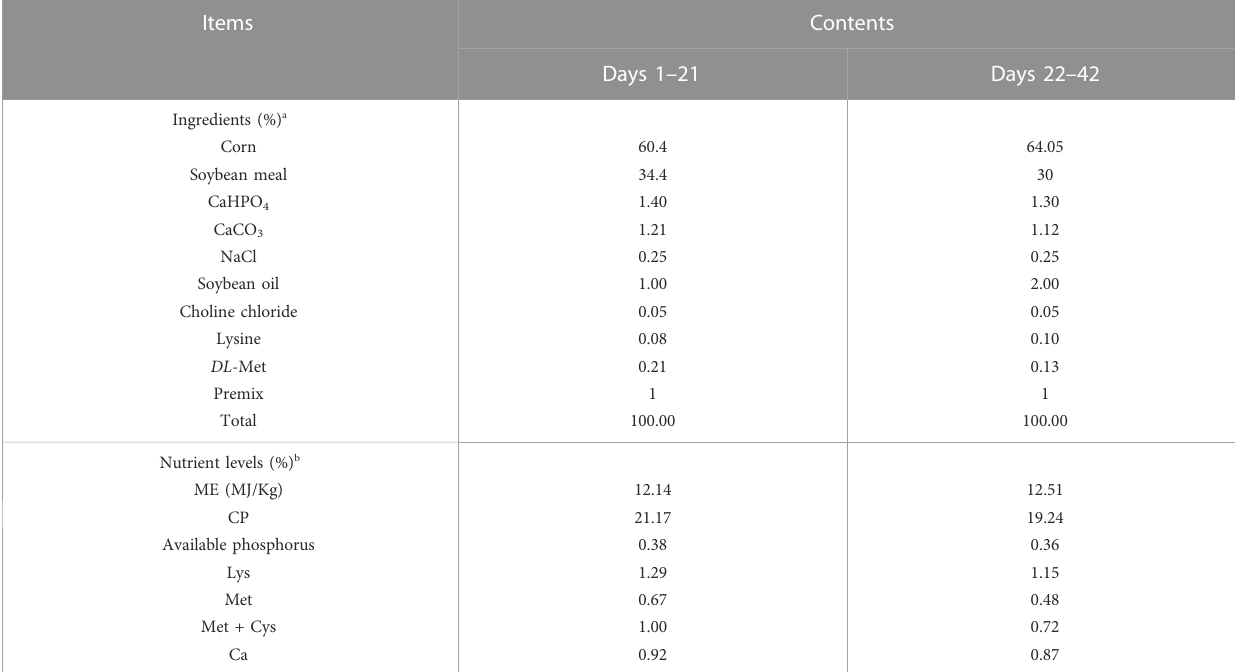
TABLE 1 Composition and nutrient levels of the basal diet.